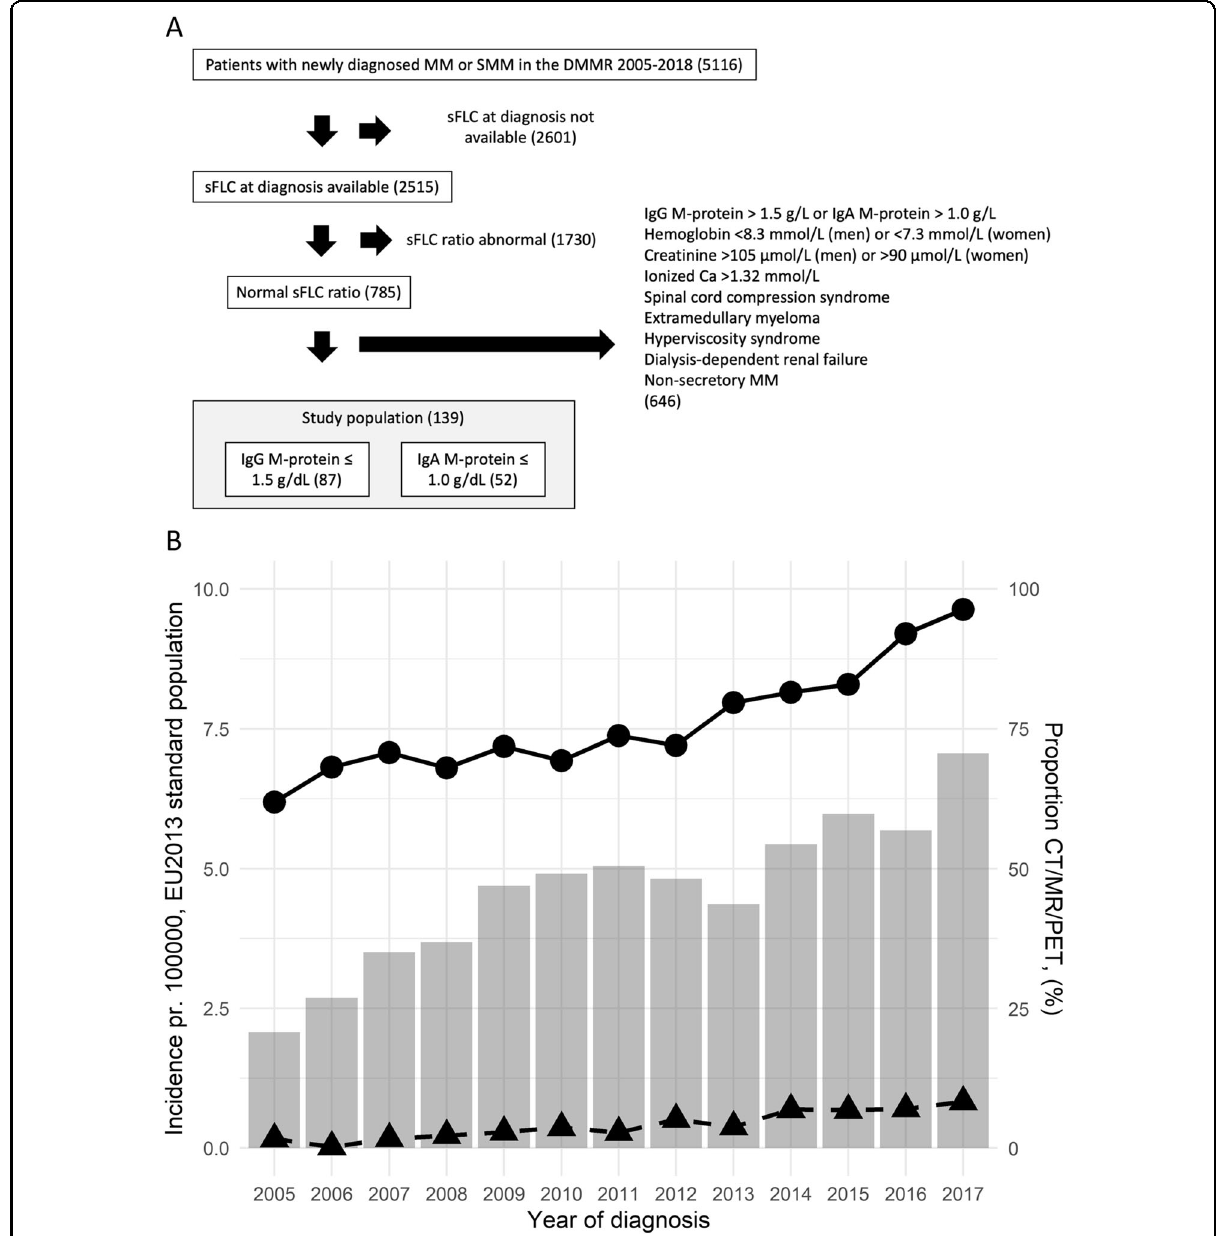
Fig. 1 Flow-chart for study inclusion and the incidence of multiple myeloma in Denmark. A Flow-chart for study inclusion: Among 5116 patients diagnosed with MM or SMM and registered in the DMMR, a diagnostic sFLC result was available in 2515 patients and 785 had a normal sFLC ratio. Of these patients, 139 had an MGUS-like phenotype IgG M-protein ≤ 1.5 g/dl or an IgA M-protein ≤ 1.0 g/dl and with normal levels of normal hemoglobin, creatinine, ionized calcium and no amyloidosis, medullary compression syndrome, extramedullary myeloma, peripheral neuropathy or dialysis-dependent renal failure at presentation. MM multiple myeloma, SMM smoldering myeloma, sFLC serum free light chain. B Incidence of multiple myeloma in Denmark: The columns with values displayed on the left vertical axis show the incidence of multiple myeloma pr. 100.000 in Denmark, age adjusted to the EU 2013 standard population. Filled circles present the age-adjusted incidence for all MM patients and the fi lled triangles present the age-adjusted incidence of myeloma patients with an IgG M-protein ≤ 1.5 g/dL and IgA M-protein ≤ 1.0 g/dL and normal blood levels of ionized calcium, creatinine, and hemoglobin. The gray bars with values displayed on the right vertical axis show the percentage of patients assessed with sensitive imaging techniques like CT, MRI, and PET (CT/MR/PET) as part of the diagnostic work-up. The years of diagnosis in the calendar period 2005 – 2017 are shown on the horizontal axis. Patients diagnosed in 2018 were not fully registered at data